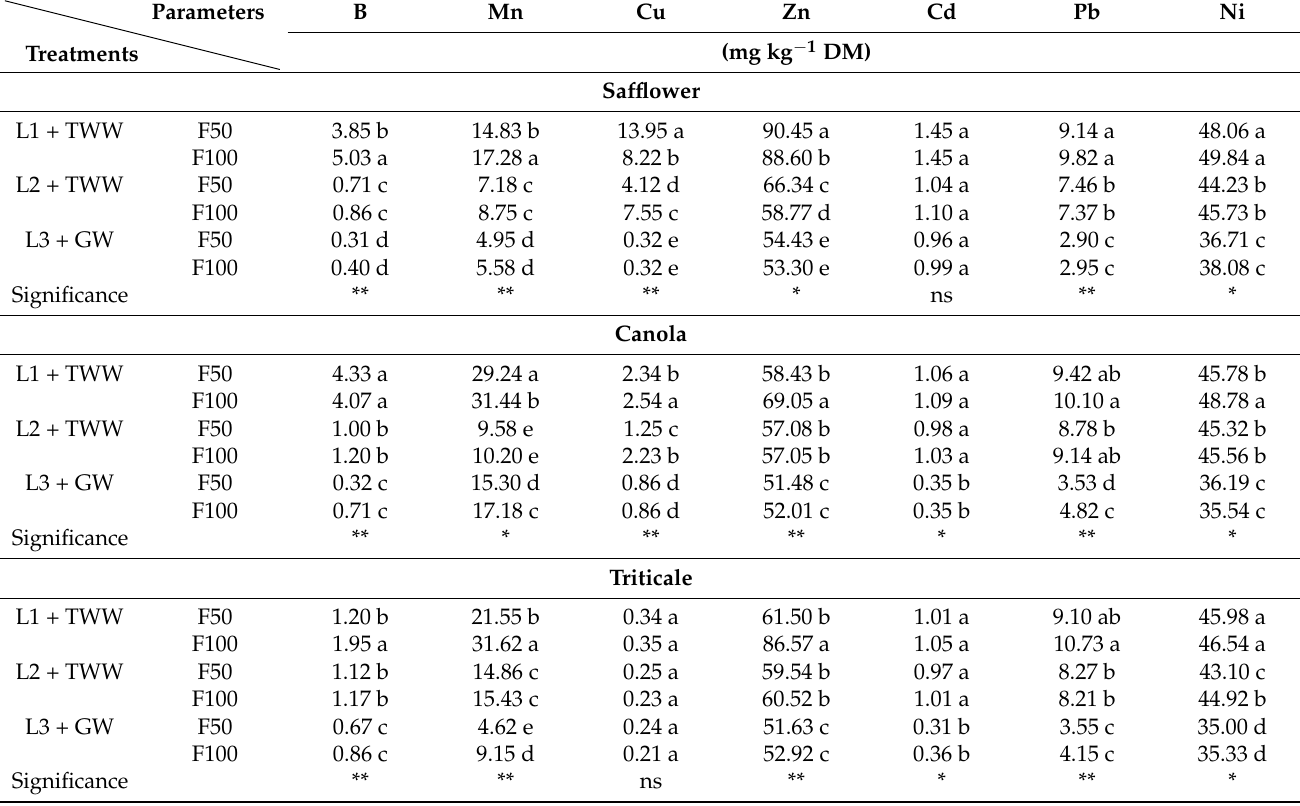
Table 6. Interaction effects of water resources and fertilization treatments on trace-elements content of safflower, canola, and